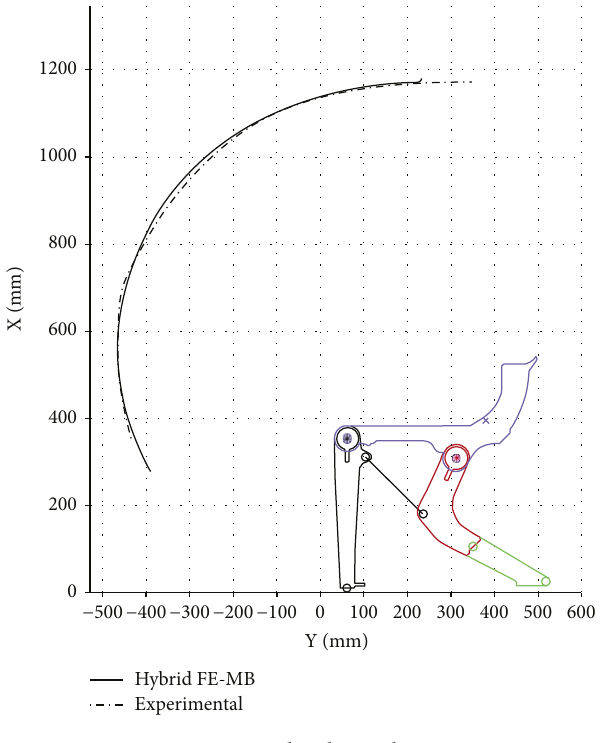
Figure 8: Head path